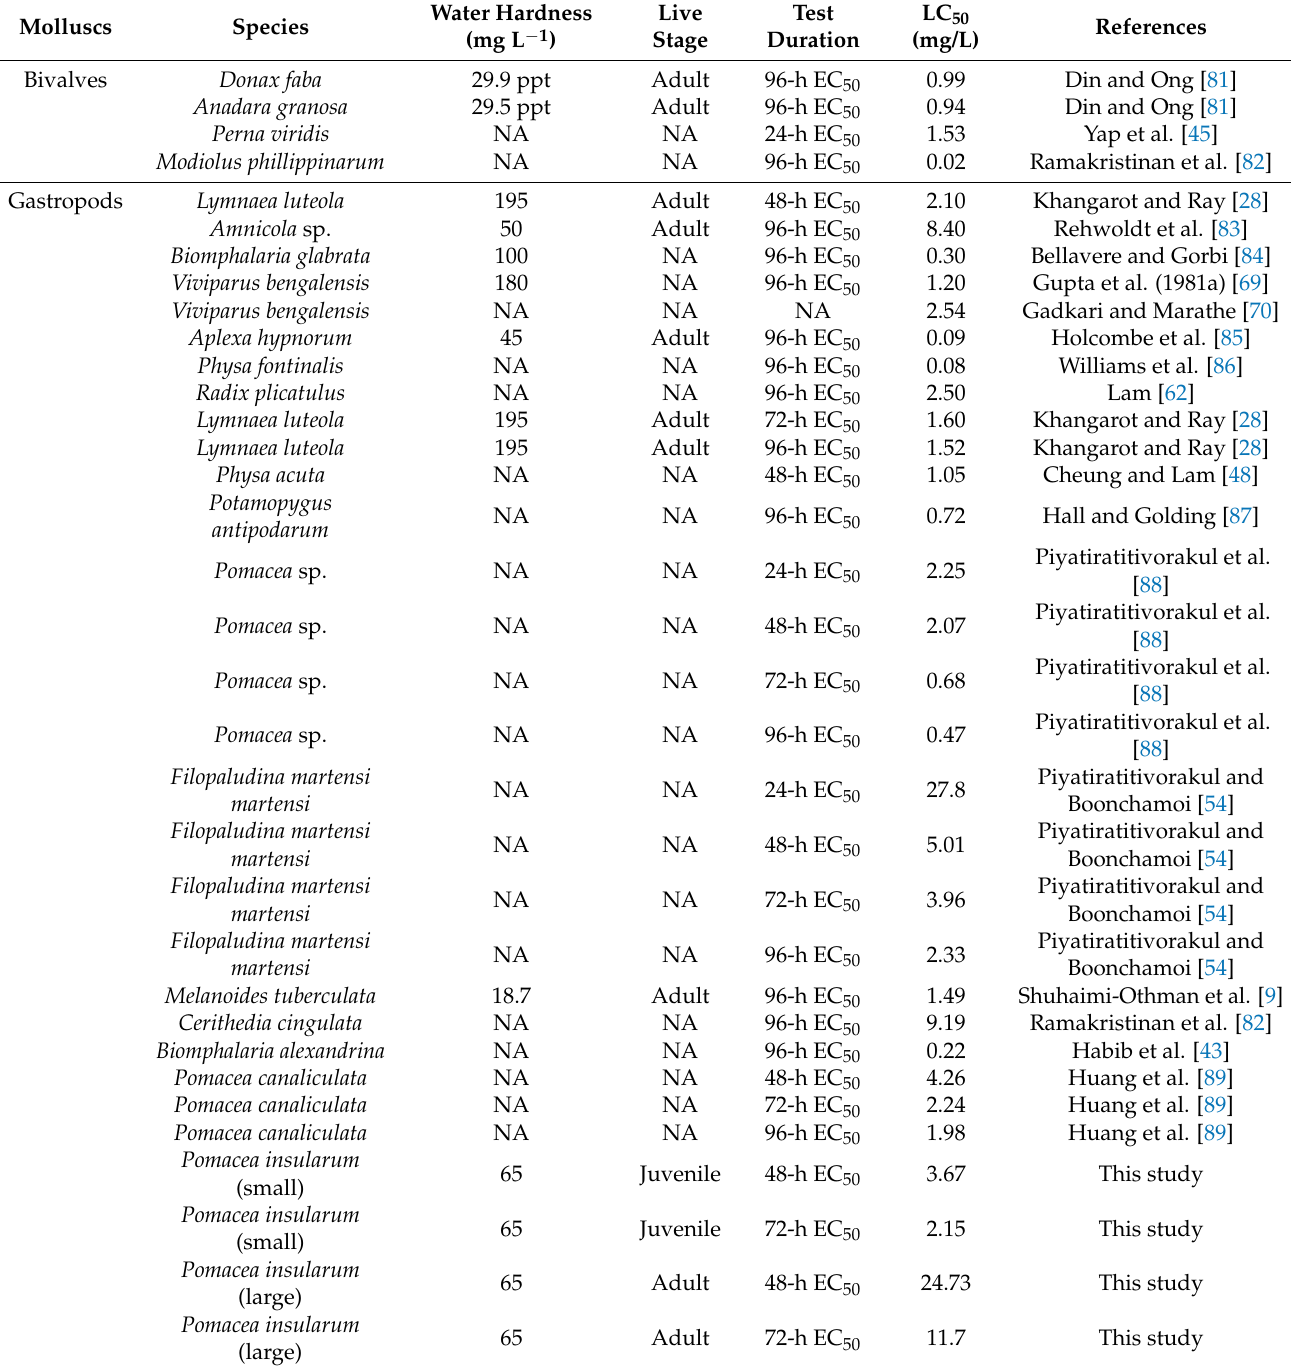
Table 2. Comparison of LC 50 values (mg/L) of Cd in Pomacea insularum with other mollusks reported in the